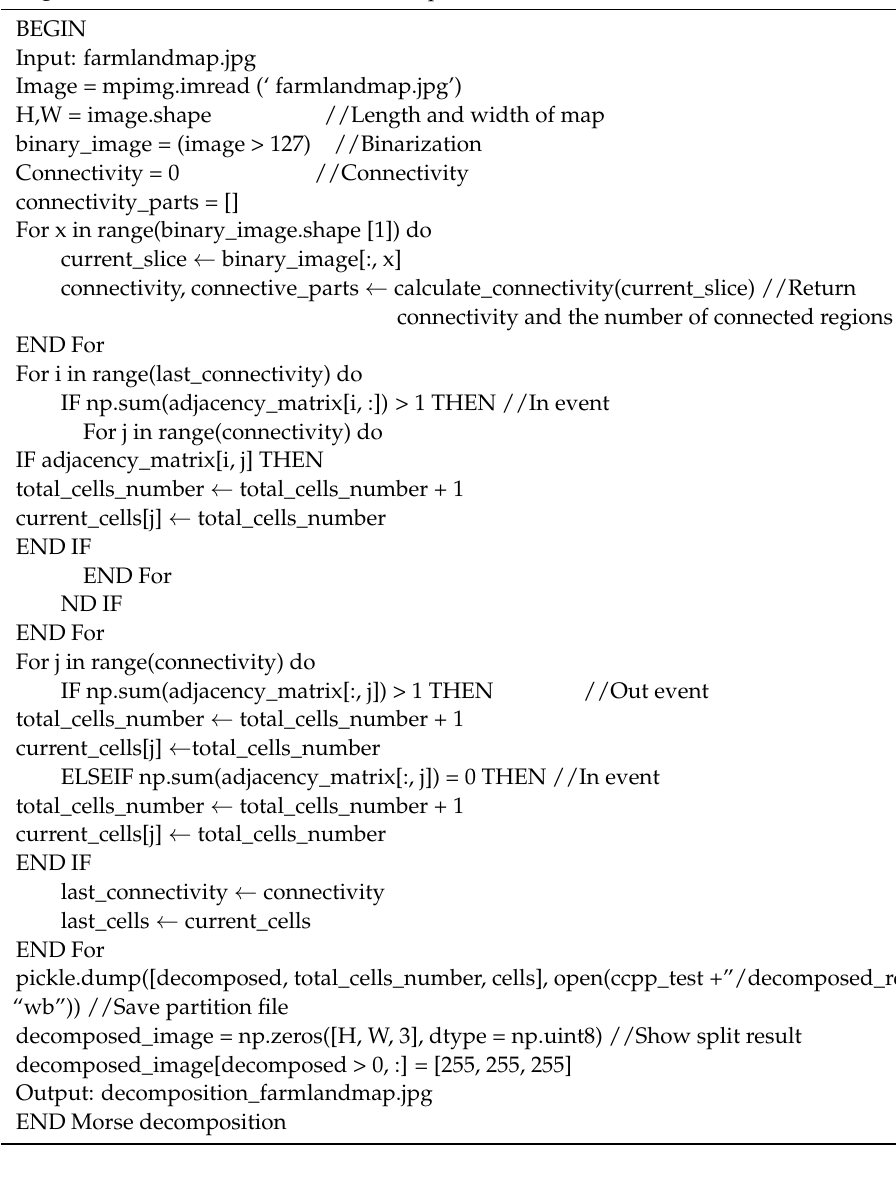
Figure 2. ( a ) Environment map; ( b ) Morse decomposition. Algorithm 1: Procedure for Morse